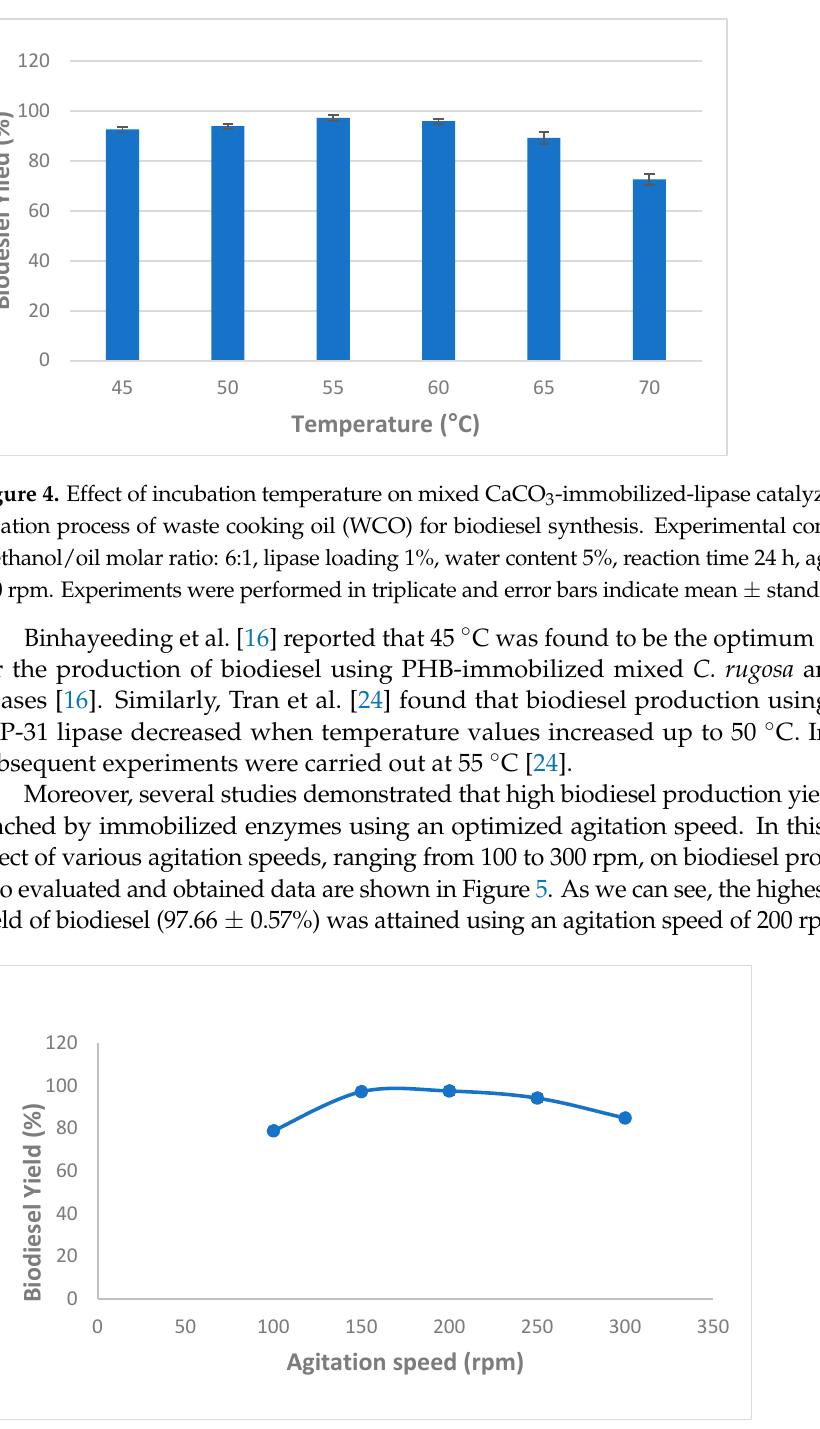
Figure 5. Effect of speed agitation on mixed CaCO 3 -immobilized-lipase catalyzed transesterification process of waste cooking oil (WCO) for biodiesel synthesis. Experimental conditions were: methanol/oil molar ratio: 6:1, lipase loading 1%, water content 5%, reaction temperature 55 °C, reaction time 24 h. Experiments were performed in triplicate and error bars indicate mean ± standard deviation .